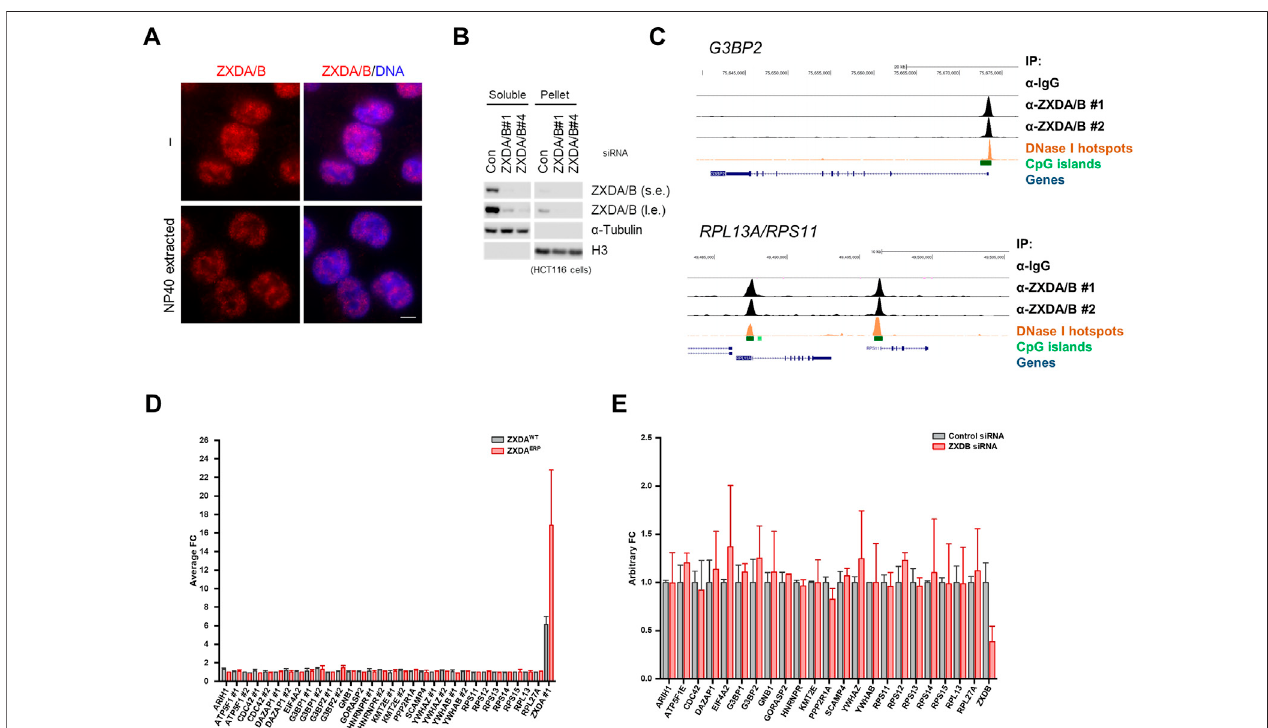
FIGURE 4 | ZXDA/B do not act as transcription factors. (A) Representative images of DNA-associated ZXDA/B in HCT116 cells. Cells were either directly fi xed or the soluble proteins were pre-extracted using a CSK buffer with 0.5% NP-40 for 10 min. DNA was visualized using DAPI. Scale bar, 5 µm (B) The HCT116 cells were subjectedtoisotoniclysis,solublefractionswerecollectedandthepelletswerefurtherlysedinthepresenceofBenzonasenucleaseandsubsequentlyheatdenaturedin thepresenceof1%SDSforinsolublefractions.Comparableamountsofsolubleandinsolublefractionswereloadedandimmunoblottedasindicated.Bothsidesof the panel represent the same exposure time; l. e. stands for long exposure, s. e. short exposure. (C) ChIP-seq tag pro fi les covering G3BP2 (upper panel), RPS11 , and RPL13A (lower panel) loci showing a high correlation between two independent ZXDA/B ChIP-seq samples. The upper tag pro fi les represent the control and two anti- ZXDA/B ChIP-seq samples. The lower panels show the location of the genes, DNase I hypersensitivity regions, and CpG islands. The scheme was generated using a UCSCGenomeBrowser(Kentetal.,2002). (D) MicroarrayanalysisofgeneexpressionintheHCT116celllinewithinducibleexpressionofwild-type(WT)ormutant(ERP) ZXDA. The cells were incubated in doxycycline for 24 h. Only genes with ZXDB-associated promoters are shown. All numbers were compared to the mean value obtainedinuntreated(non-induced)control.The fi nalvaluerepresentsthemeancalculatedfromtwoindependentexperiments. (E) RNA-seqanalysisoftheHCT116cell line transfected with two different control siRNAs and two siRNAs targeting ZXDB. All counts (FKPM) were compared to the average count obtained in control samples. Only genes with ZXDB-associated promoters are shown.